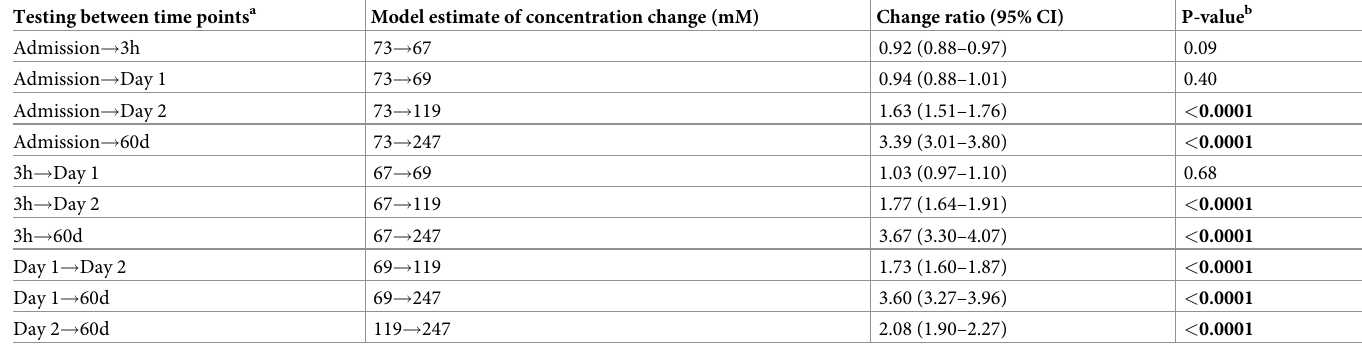
Table 2. Model estimates of total LPC concentration and the corresponding ratio of change between the sampling time points.